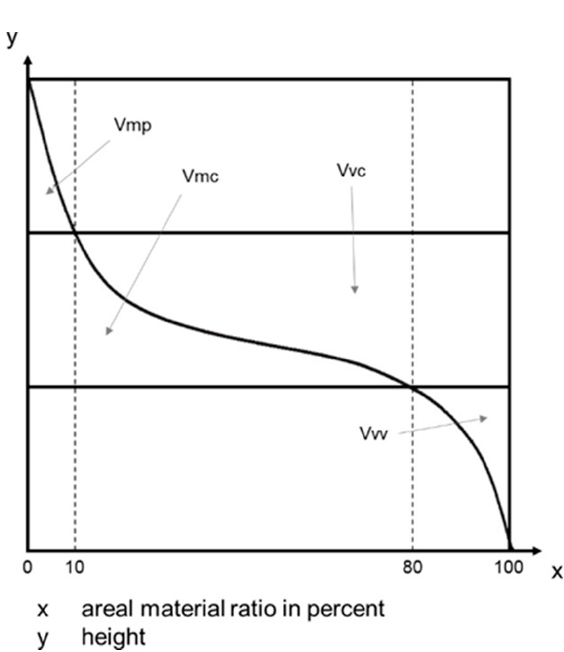
Figure 4 . Void volume and material ratio parameters. Inspired by [21]. Figure 4. Void volume and material ratio parameters. Inspired by